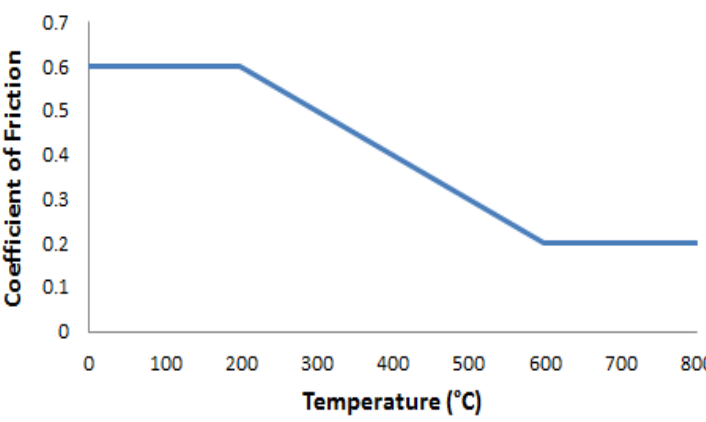
Figure 2. Friction as a function of